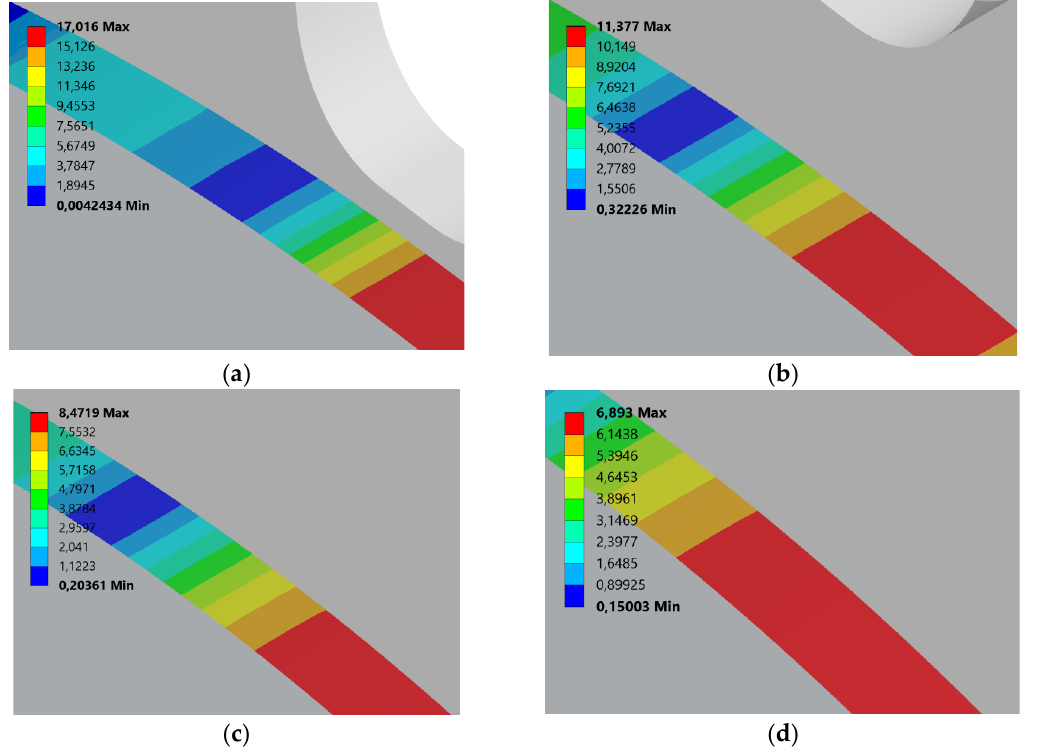
Figure 16. Shear stress results for hybrid gears generated rack tip radius, ρ 1 = 0.3 xm for different RTs; ( a ) 0.5 xm, ( b ) 1 xm, ( c ) 1.5 xm, ( d ) 2 xm.